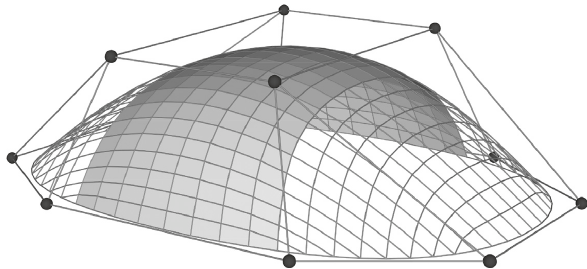
Figure 18: The control structure and the preoptimized geometry derived by a subdivision rule.